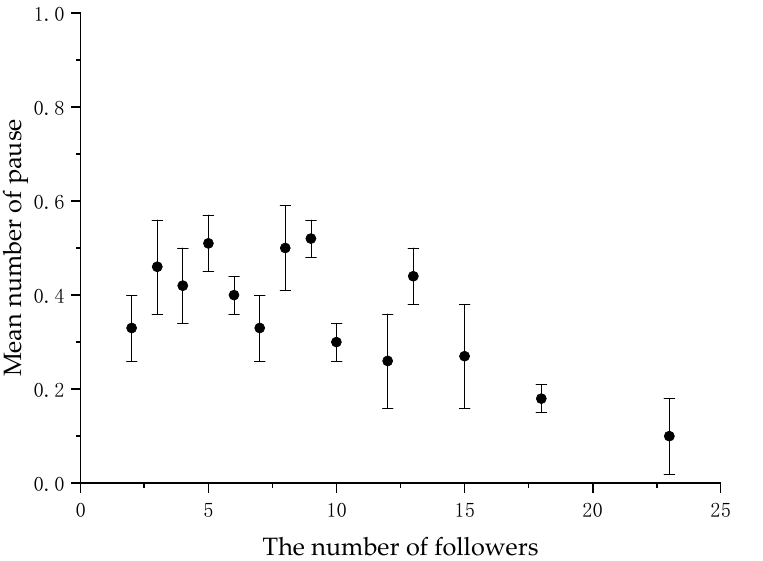
Figure 2. Mean frequency of the initiator’s pause per collective movement according to the number of followers. Table 2. Summary of analysis outcomes. Hypothesis